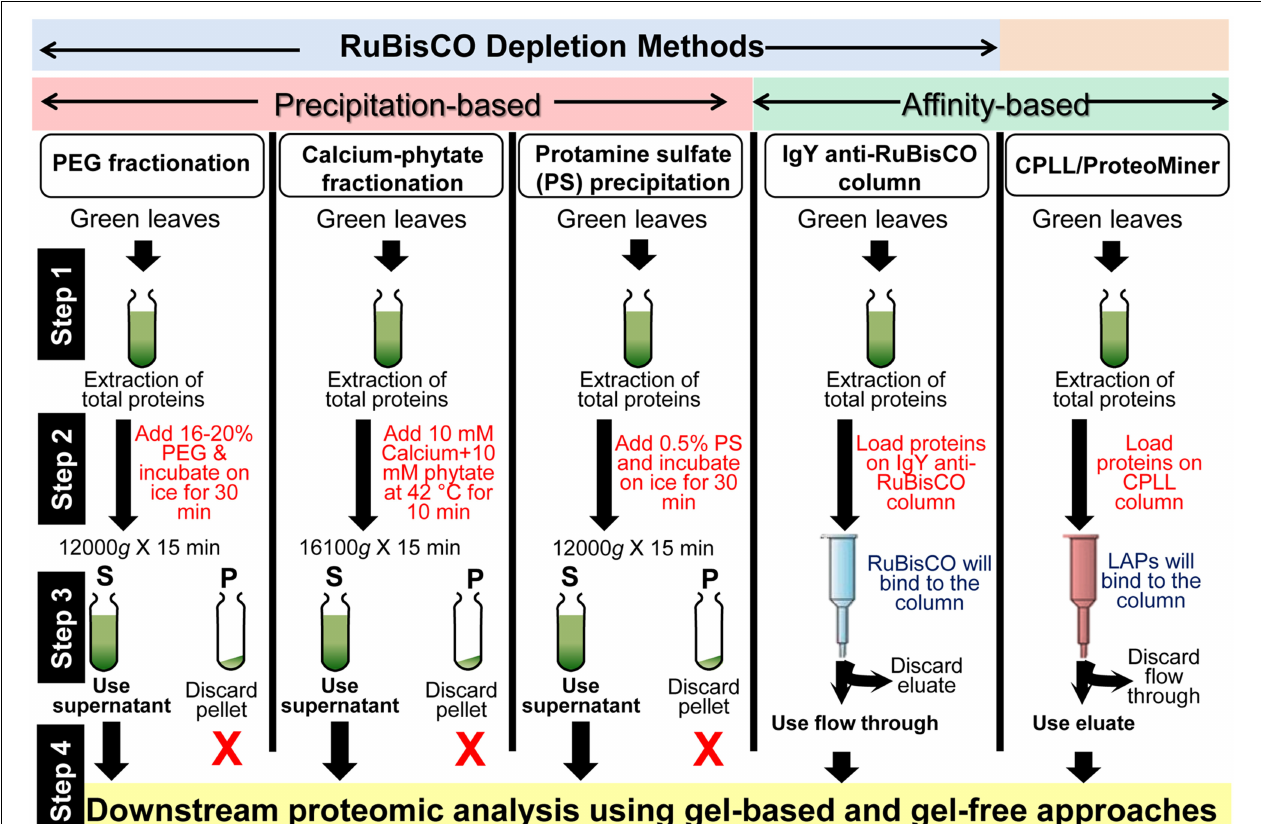
FIGURE 1 | A summary of the workflows for the enrichment of LAPs in plants using RuBisCO depletion and CPLL methods. Details of these techniques are mentioned in the text and cited